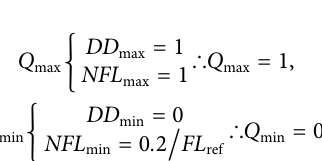
FIGURE 1 | The effect the type of mixing on the pulp yield, fi nes and lignin content in the DES-cooking of Asplund (1 h of cooking and the L/W at 27:1) by using mechanical stirring (MS) and Rota-evaporator (RE) at 100 ° C (A) and at 130 ° C (B) .